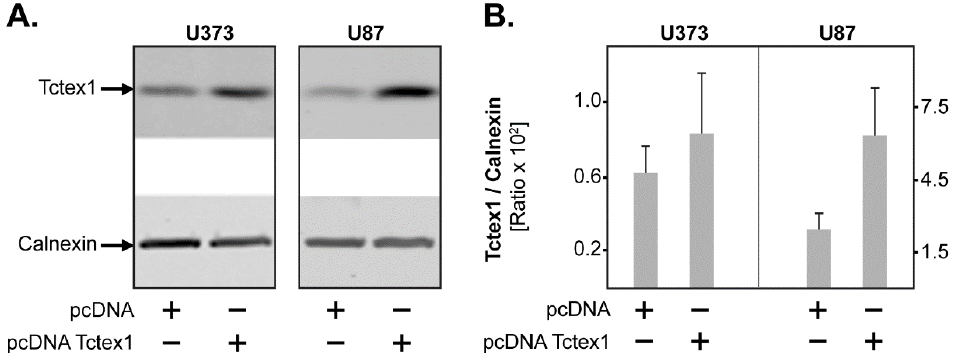
Figure 3. Tctex1 overexpression in GBM cell lines. U373 and U87 GBM cells were transfected with a Tctex1 overexpression plasmid (pcDNA Tctex1) or the control plasmid (pcDNA). After antibiotic selection, the cells were lysed and analyzed by Western blot, using Tctex1-specific antibodies. ( A ) Representative Western blot showing Tctex1 expression in pcDNA versus pcDNA Tctex1 cells. Calnexin was used as the loading control. ( B ) Tctex1/Calnexin ratio in pcDNA versus pcDNA Tctex1 GBM cells. Shown are the means + S.D. of 3 independent cell lysates.